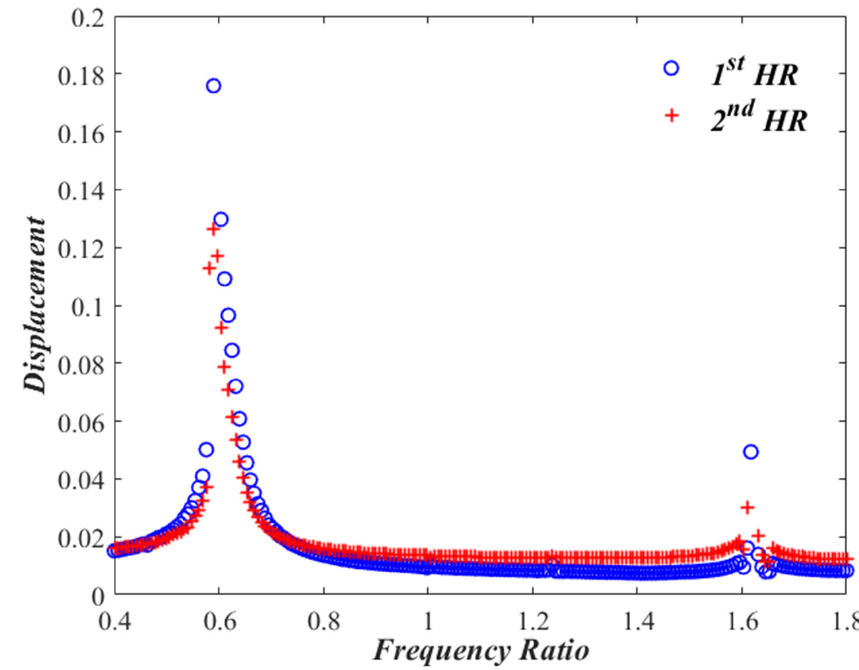
Figure 4. Frequency response curves for 𝑥 (cid:2869),(cid:2870) of the nonlinear dual HR (Case I).